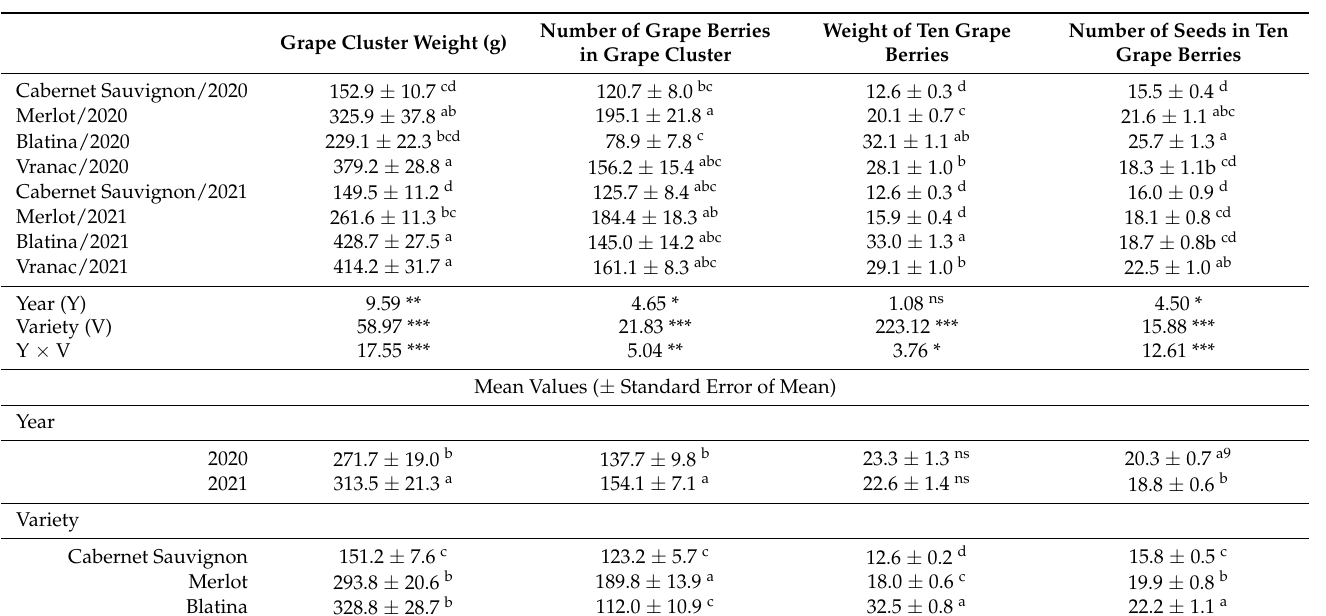
Table 4. Grape cluster characteristics of the analyzed varieties during the research period at the Mostar